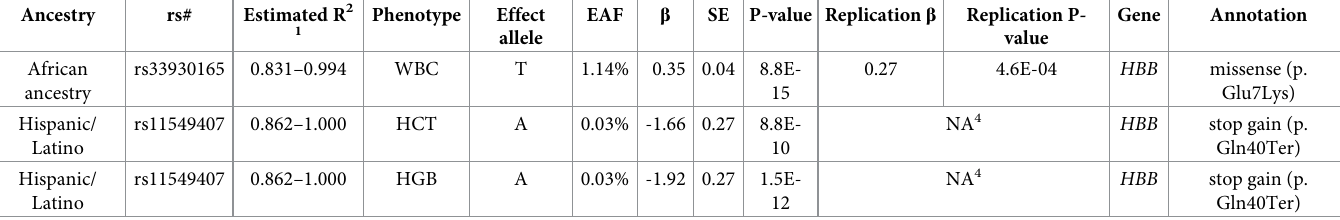
Table 3. Novel variants detected in TOPMed freeze 5b imputed Hispanic/Latino and African ancestry cohorts, in association analyses with white blood cell count, hemoglobin, and